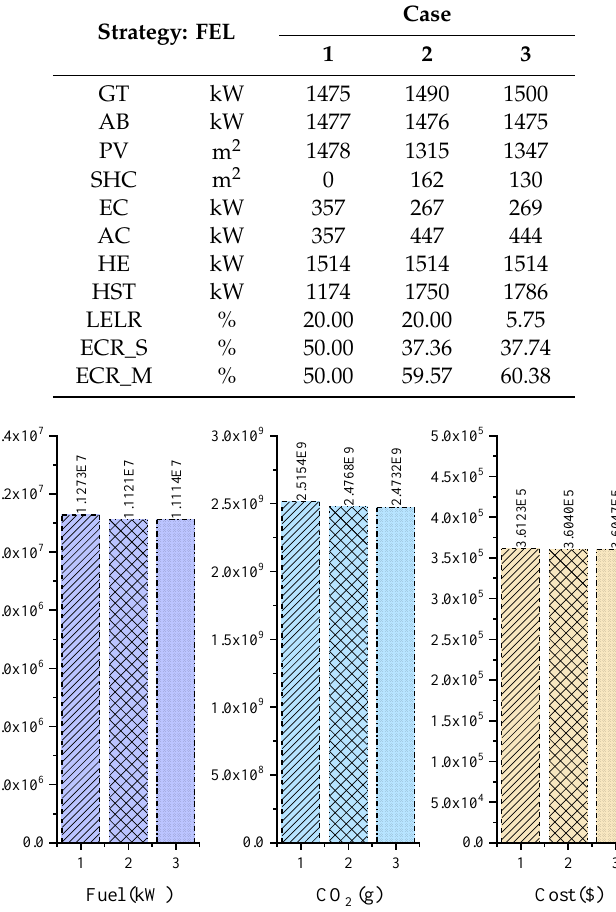
Figure 6. Fuel consumption, CO 2 emission, and cost of the deterministic cases in following the electric load (FEL).